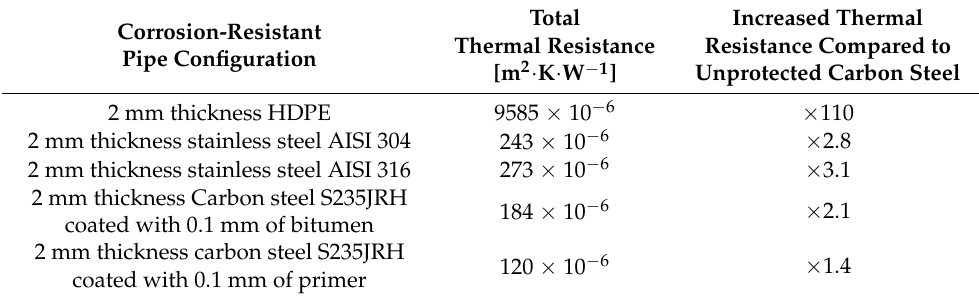
Table 5. Thermal resistance of different corrosion-resistant, pipe-coating systems, and how they compare to an unprotected carbon steel pipe 2 mm